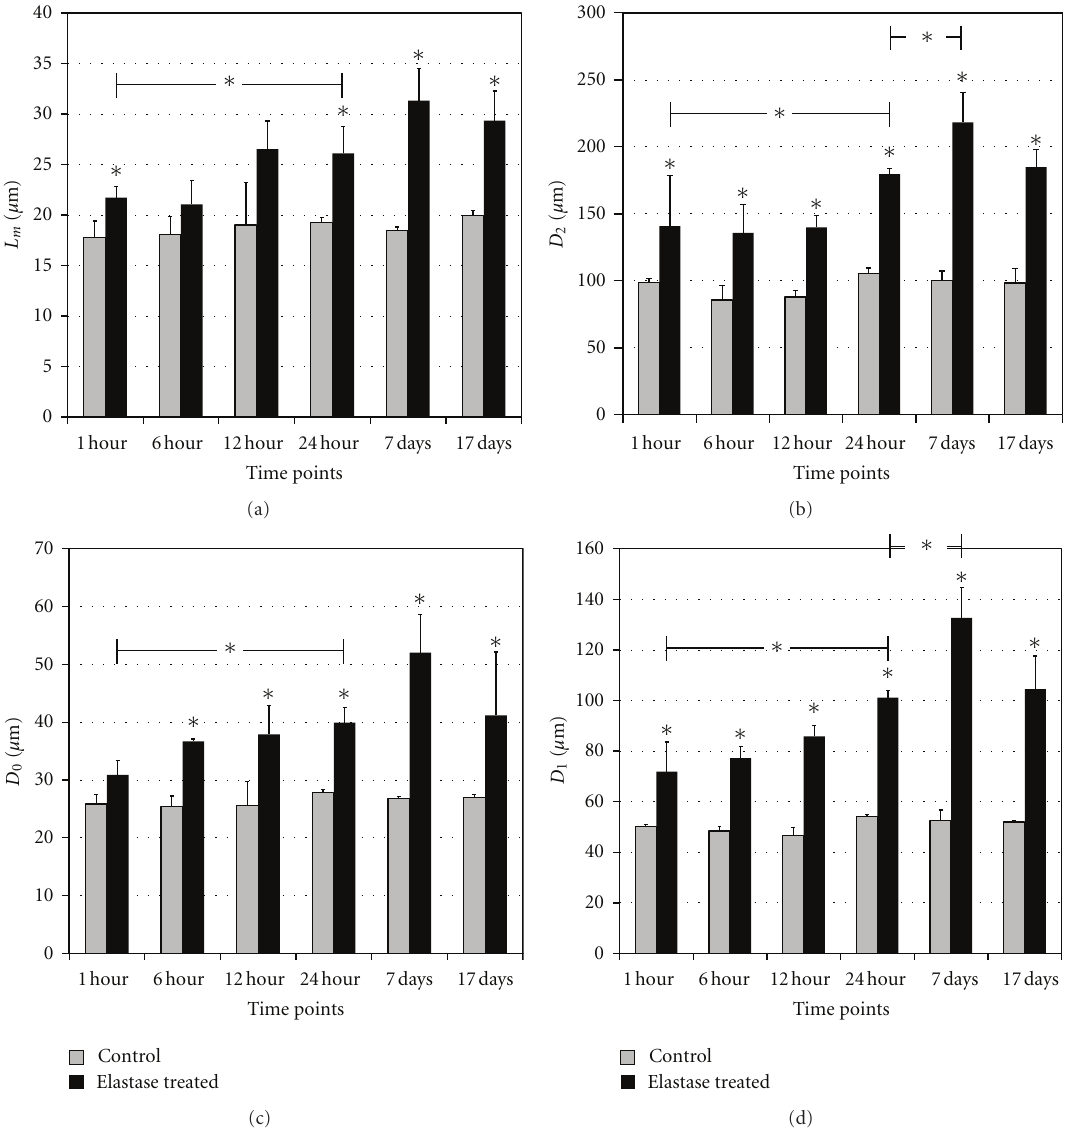
Figure 7: Evolution of L m (a), D 2 (b), D 0 (c), and D 1 (d) descriptors at di ff erent times after elastase instillation. D 2 is the mean equivalent diameter, D 1 and D 2 are weighted indexes of airspace size distribution, and L m is the mean linear intercept. Statistically significant di ff erences between the control ( C ) and the elastase-treated ( E ) groups are indicated as well as di ff erences between successive time points in the elastase group ( P < 0 . 01, ∗